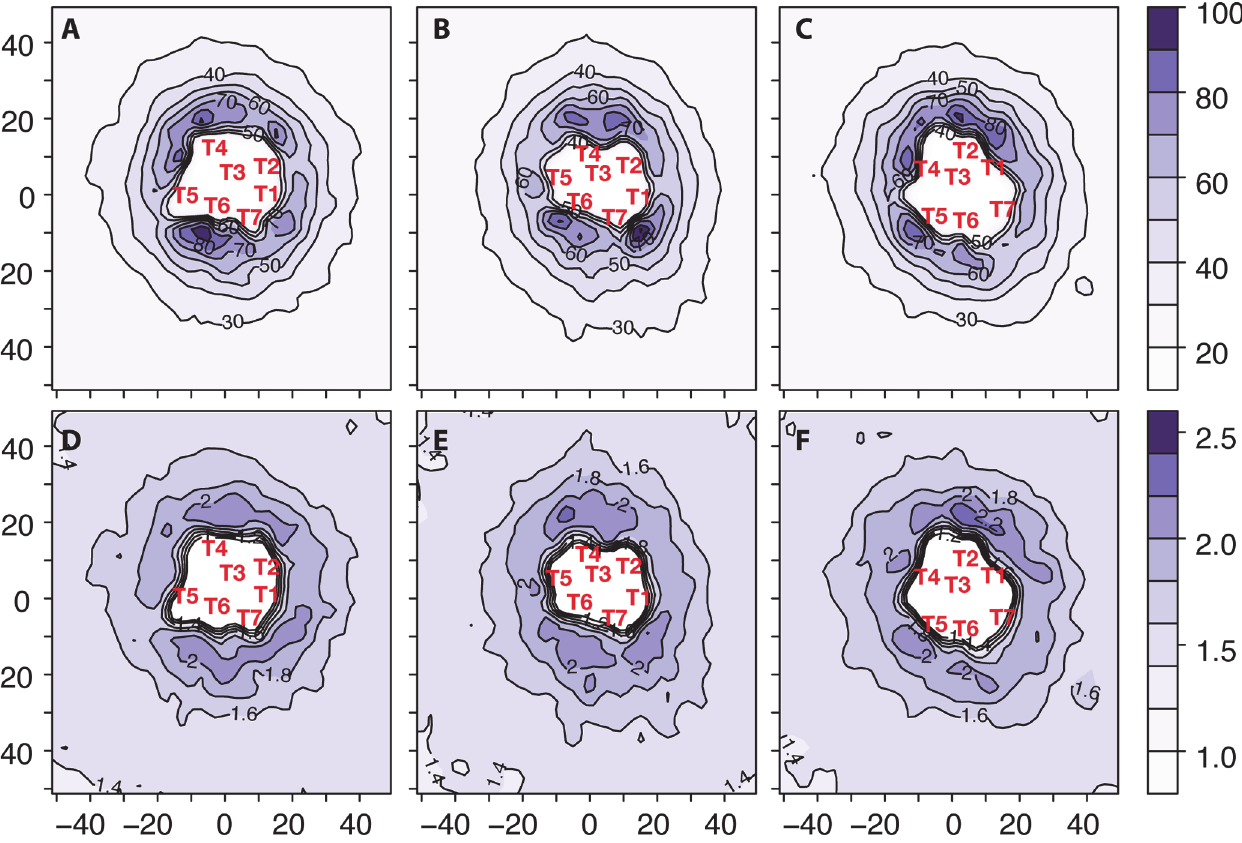
Fig 5. Persistence times and persistence-to-exchange time ratios of lipid molecules derived from the OR homo-dimer simulations. Specifically, persistence times of lipid molecules calculated for δ -OR/ δ -OR, κ -OR/ κ -OR, and μ -OR/ μ -OR are reported, in ns, in panels A, B, and C, respectively. Persistence-to-exchange time ratios of lipids around isolated δ -OR, κ -OR, and μ -OR are shown in panels D, E, and F, respectively. Approximate locations of the centers of mass of the seven transmembrane helices (TM1-TM7) are indicated with red labels.